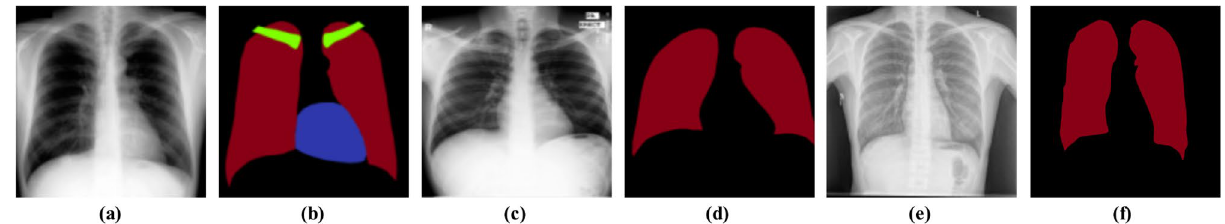
Figure 3. Input images and labels from three datasets: ( a ) radiographic X-ray image of the chest from JSRT dataset, ( b ) JSRT dataset labels of the lungs, clavicels and heart, ( c ) X-ray image of the chest from MCCXR dataset, ( d ) MCCXR dataset lungs label image, ( e ) chest X-ray image of SCXR dataset, and ( f ) SCXR dataset lungs label